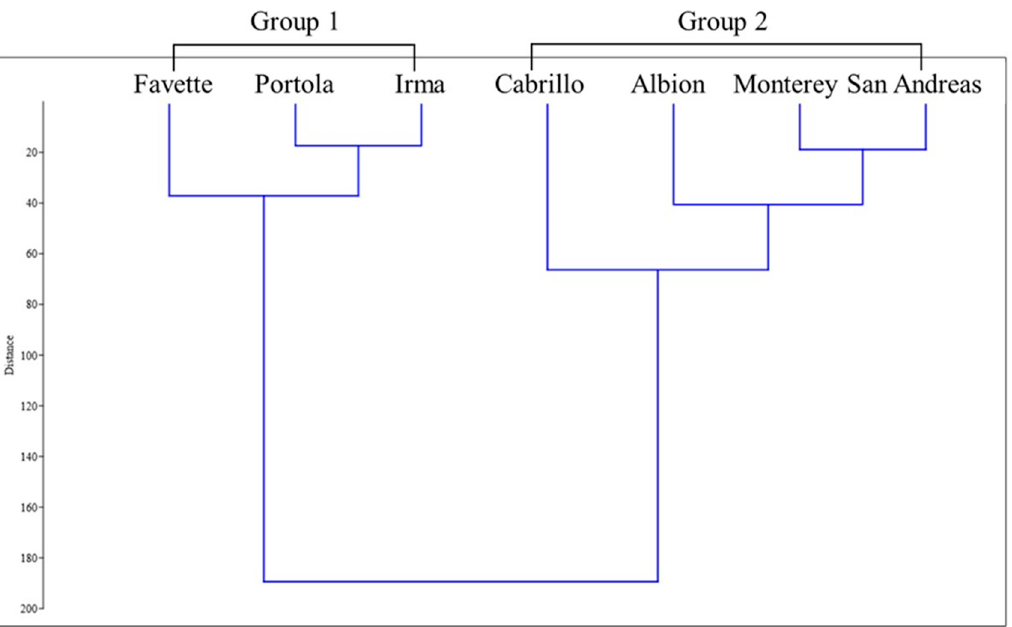
Figure 4. Hierarchical clustering performed with a paired group algorithm and considering Wards methods of Euclidean distance to measure the mean values of each of the seven strawberry cultivars characterized for total acidity (TA), soluble solid content (SSC), dry matter (DM), total phenols content (TPC), antioxidant activity (AA), and total monomeric anthocyanin (TMA). In detail, Favette (located in a separate sub-cluster), Portola and Irma (located in